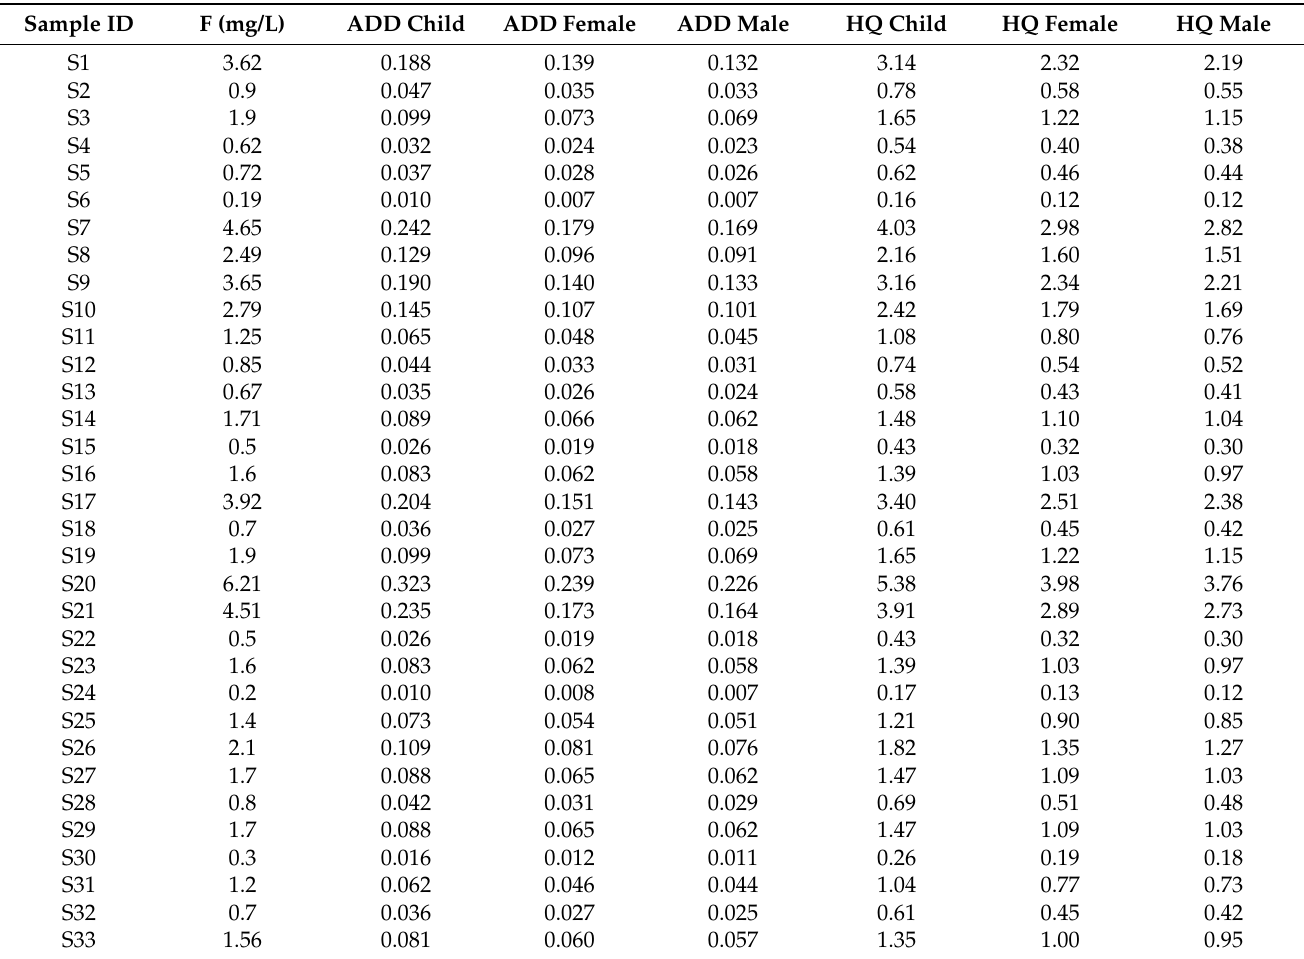
Table 4. Health risk exposure assessment in the form of average daily ingestion (ADD), and hazard quotient (HQ) for children and adults consuming fluoride-contaminated groundwater of Quetta city, Pakistan ( n =